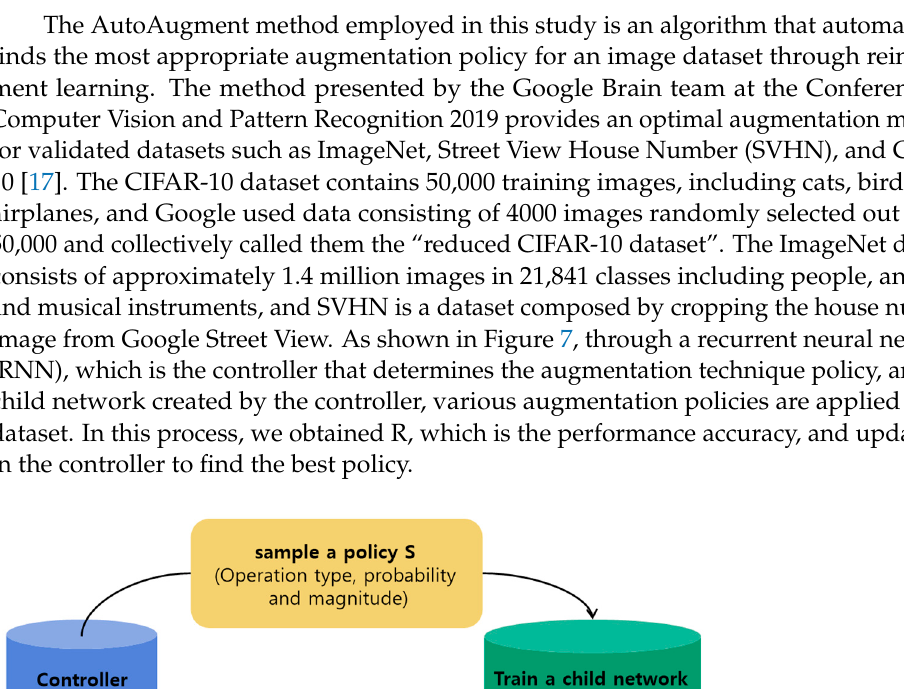
Figure 6. Generator architecture of the deep convolutional generative adversarial network (DCGAN).